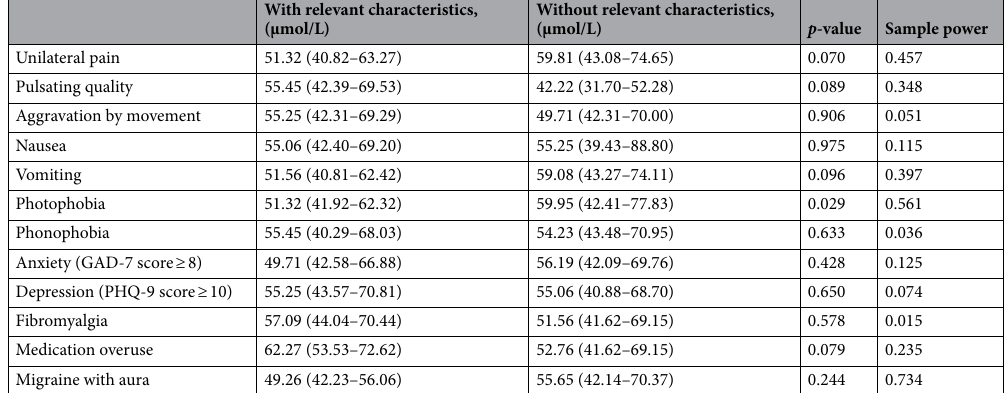
Plasma levels in non-users of the corresponding class of preventive medications, (μmol/L) p -value Sample